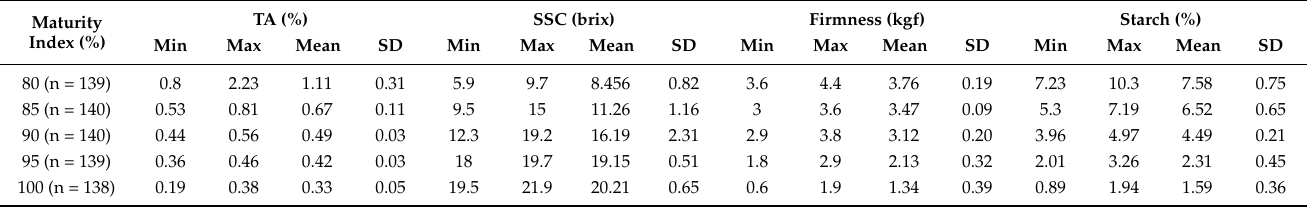
Table 3. Summary statistics of TA, SSC, firmness, and starch for the Arumanis mango maturity